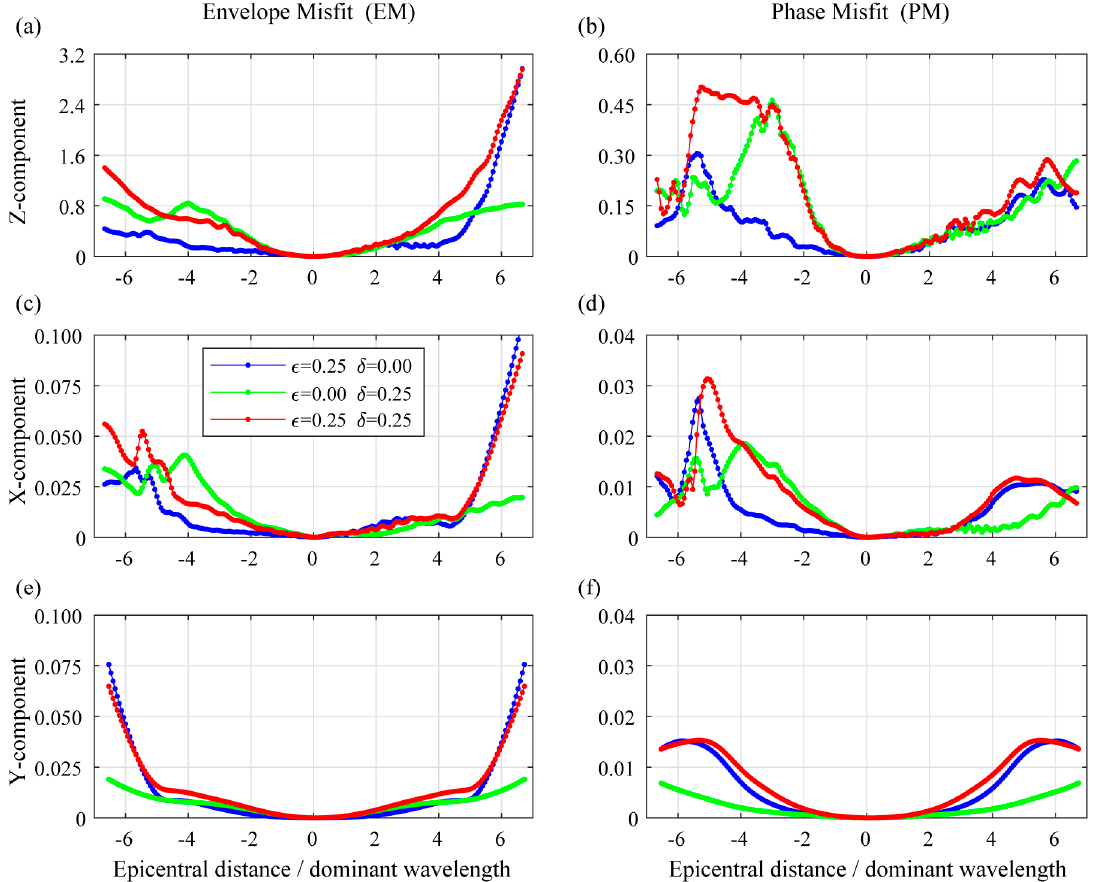
Figure 10. Envelope misfit and phase misfit of detectors’ three-component waveforms (TTI model). The meanings of each line and axis are similar to Figure 6.